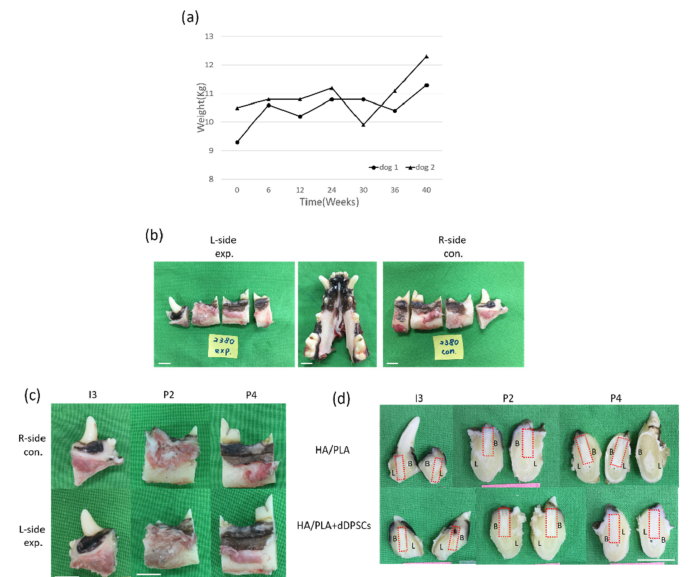
Figure 5. ( a ) The body weight of the experimental animals after the experiment. ( b , c ) Photographs from the tissues in dogs. Horizontal ramus of the dog mandible in lingual view. ( d ) Gross observation of buccal-lingual section of tooth engineered. L-side: left side; R-side: right side; I3: the third incisor; P2: the second premolar; P4: the fourth premolar. B: Buccal side; L: lingual side. Scale bar: 1